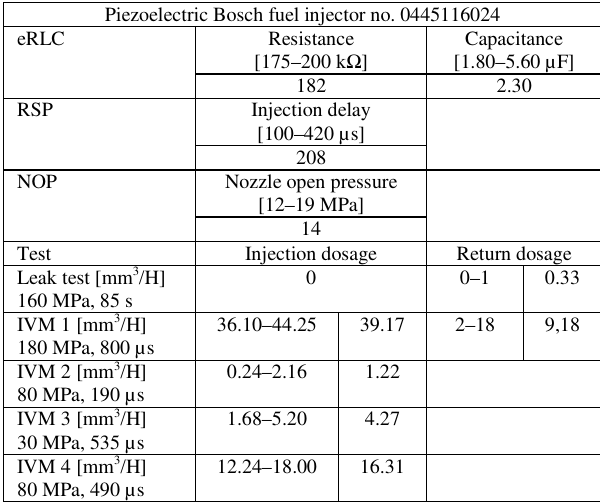
Table 1. Test results of good working electromagnetic Bosch fuel injector research